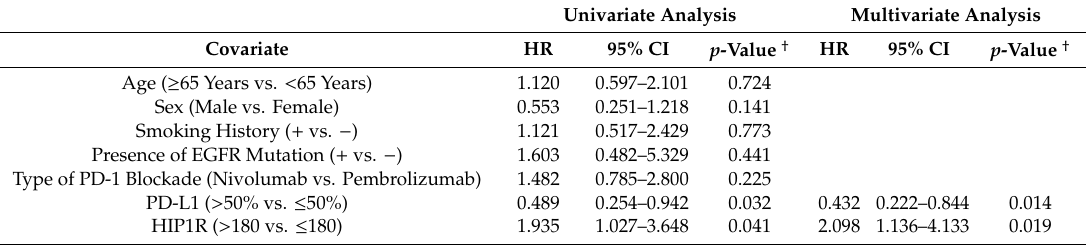
factor receptor; HIP1R, Huntingtin Interacting Protein 1 Related; HR, hazard ratio; PD-1, programmed cell death protein 1; PD-L1, programmed death-ligand